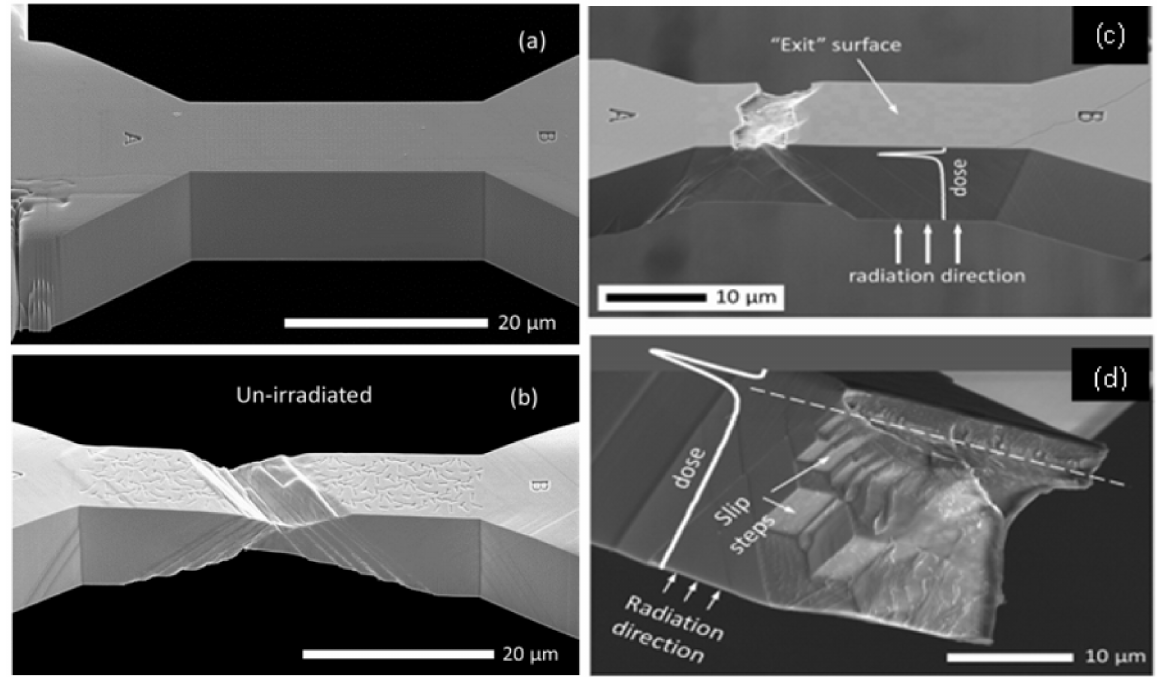
Figure 12. SEM image of unirradiated tensile sample ( a ) prior to testing and ( b ) after testing, exhibiting ≈ 56% plastic elongation; irradiated tensile sample ( c ) post-tensile test (top surface) showing almost brittle fracture, ( d ) fracture surface of specimen showing slip steps stopping a micron below top surface, with the marked line showing the limit of propagation of the slip lines [23].